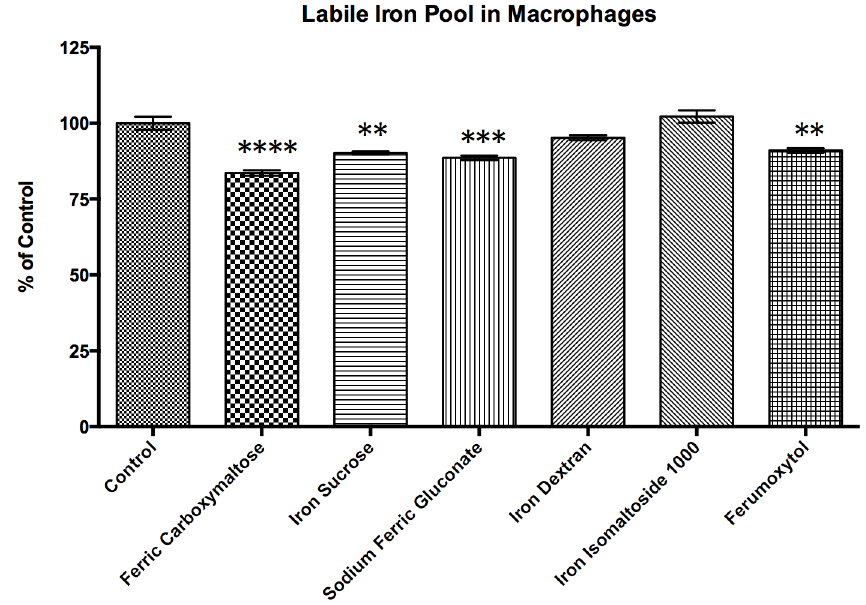
Fig 7. Labile Iron Pool assessment of rat peritoneal macrophages through Calcein AM Assay. Rat peritoneal macrophages were obtained by peritoneal lavage. The cells were exposed to 0.1 mg/ml of elemental iron for each of the iron formulations for 24 hours. After 24 hours, the cells were washed and incubated with Calcein AM working solution. Fluorescence was quantified on a fluorescent plate reader at excitation/emission wavelengths of 490/520 nm. When calcein binds to iron the fluorescent activity is quenched, thus more available iron is reported as decreased fluorescent activity. All data shown are means ± SEM of three independent observations in separate cell culture wells. The data show that exposure to ferric carboxymaltose, iron sucrose, sodium ferric gluconate, and ferumoxytol are associated with an increase in labile iron pool compared to control (untreated), but there is no significant increase following iron dextran or iron isomaltoside 1000 exposure ( ** , p < 0.01; *** , p < 0.001; **** , p < 0.0001).